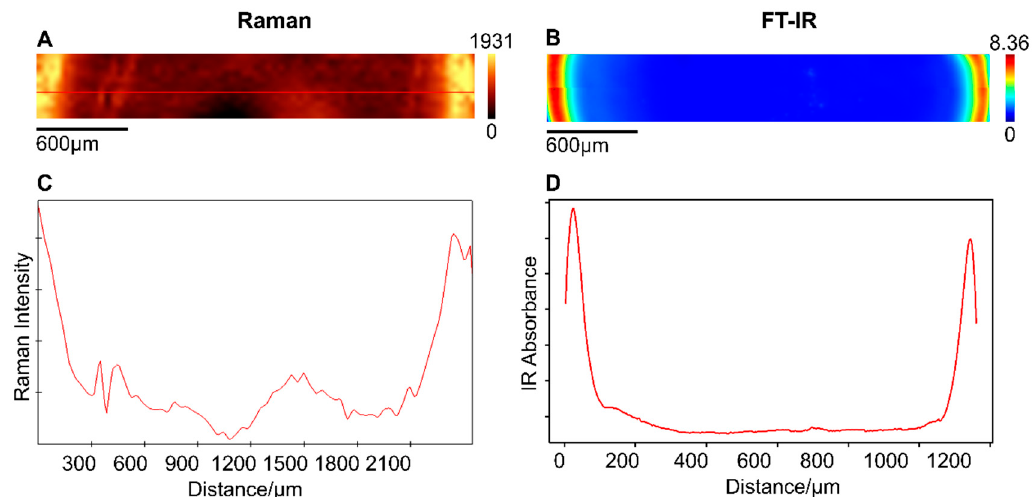
Figure 1. False color ( A ) Raman image and ( B ) FT-IR image of the dried plasma droplet showing intensity distribution of amide I vibrations around 1660cm − 1 along with ( C ) Raman and ( D ) FT-IR intensity profile from the transverse axis.